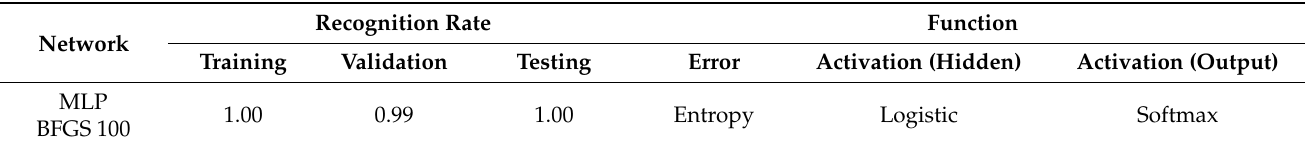
Table 3. Results of the MLP network training